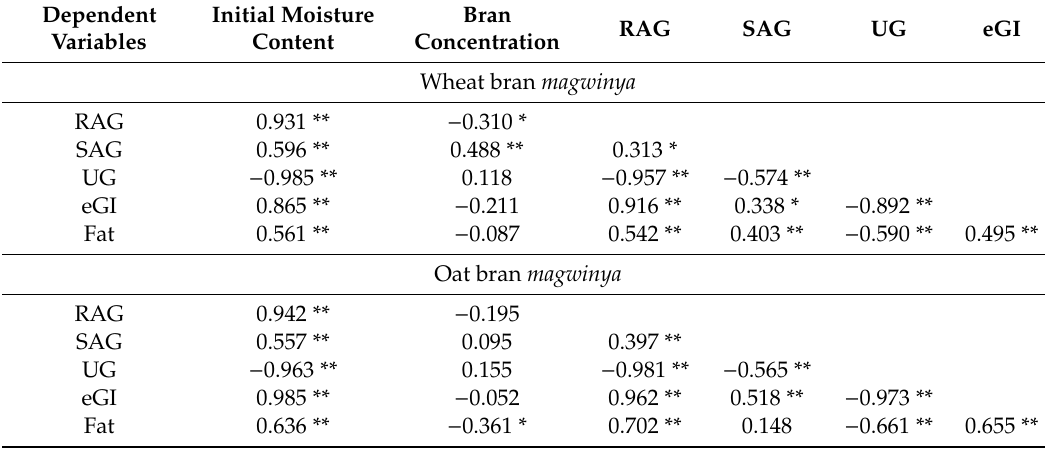
Table 3. Correlation coe ffi cients of independent variables, glucose, and estimated glycaemic index of wheat and oat bran magwinya